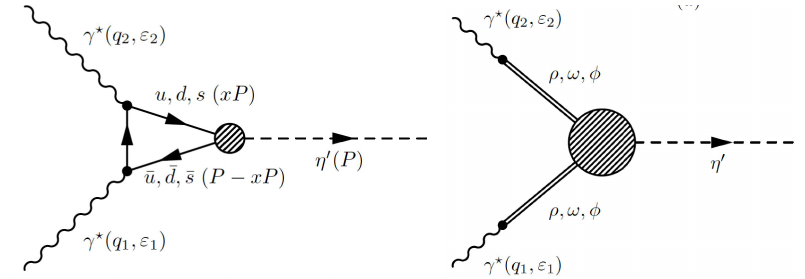
where α is the fine structure constant, (cid:15) 1 , 2 and q 1 , 2 are the polarization vectors and 4-momenta, respectively, of the two virtual photon, (cid:15) µνβγ is the Levi-Civita tensor, and F η (cid:48) is the TFF. The photons are space-like and so the q 2 are negative. It is thus convenient to define Q 2 1 , 2 so that the arguments of the TFF are positive.